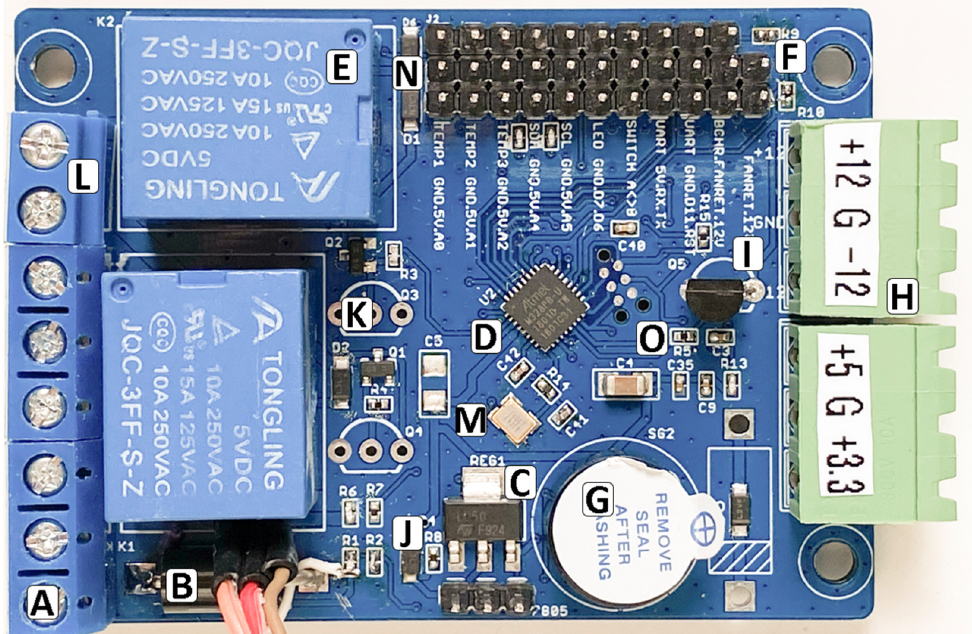
Figure 8. Top view of the MCU board: A—Input heads, B—Diode, C—Regulator, D—Microcontroller, E—Relay, F—Voltage divider, G—Buzzer, H—Output header, I—Transistor, J—Voltage dividers, K—Relay circuit, L—Fuse header, M—Oscillator Circuit, N—Diodes and header, O—Voltage divider and decoupling capacitors.